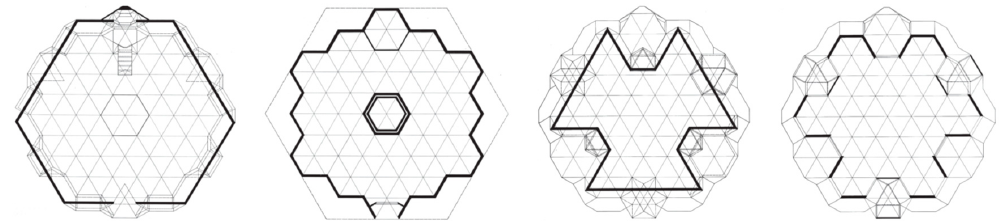
Figure 8. The Military Officers’ Academy Synagogue in Mitzpe Ramon. Different forms of the building envelope along the vertical axis. Courtesy of Zvi Hecker, Architect. Used with permission .